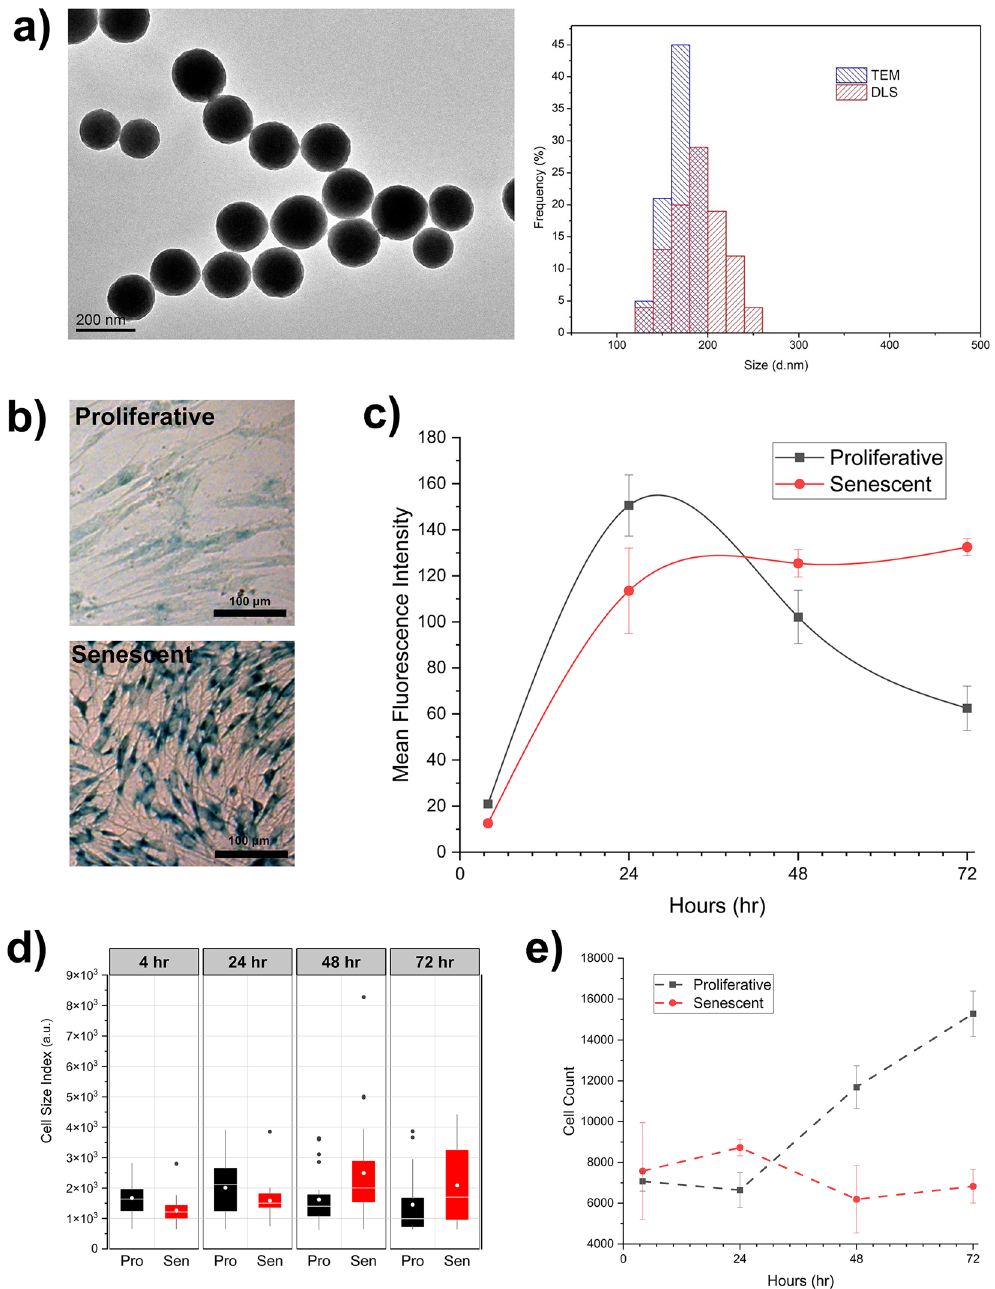
Figure 1. Cellular uptake kinetics of SiNPs of the 200 nm size range in proliferative and senescent WI-38 fibroblasts over a 72 h timecourse. ( a ) Electron micrographs of SiNPs. The histogram to the right shows TEM and DLS measurements. ( b ) Staining for SA-β-gal activity at 48 h to confirm cellular senescence (bluish-green stain). ( c ) Flow cytometry results for cells incubated continuously with 6.25 µg/ml of SiNPs. Error bars indicate S.E.M. (n = 3). ( d ) Box plot for cell size indexes over time (n = 25 for each condition) . ( e ) Graph shows the amount of cell proliferation over time. Error bars indicate S.E.M. (n =